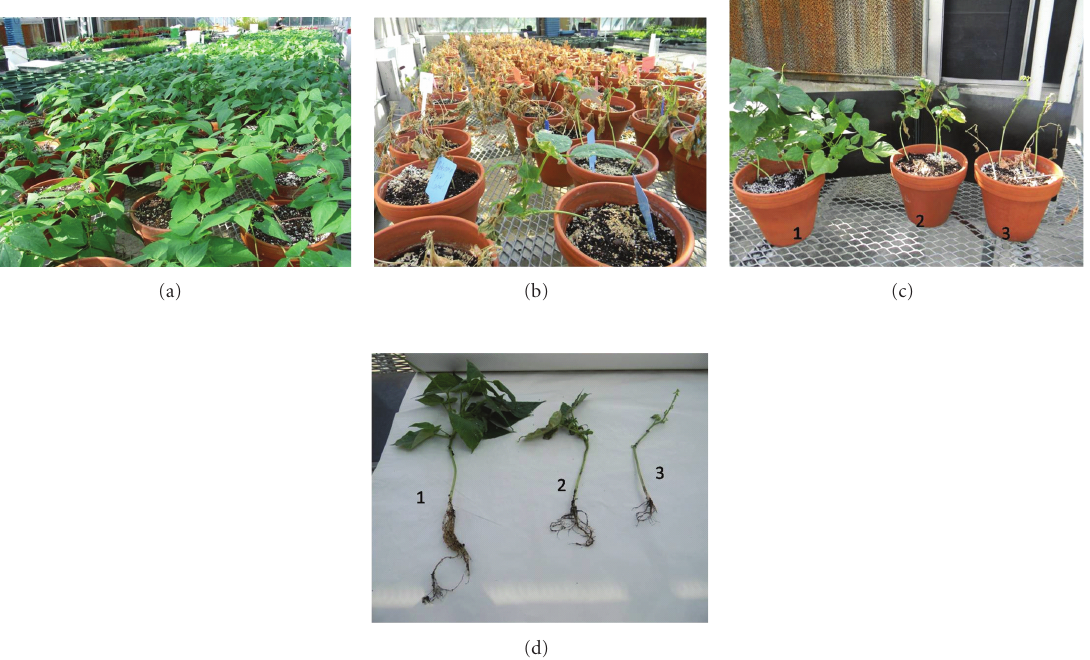
Figure 6: Drought tolerance assays. (a) “Matterhorn” plants before drought induction; (b) after 21 days of continuous water withholding; (c) “Matterhorn” drought recovered plants after water reapplication; 1: control non-transgenic plant that was watered throughout the experiment; 2: “Matterhorn” transgenic plant after 21 days of no-irrigation, 3: wild-type non-transgenic plant after 21 days of no-irrigation; (d) root growth in plants after 21 days of drought stress. 1: Control non-transgenic plant roots; these were watered daily, 2: transgenic plant roots after 21 days of no-irrigation, and 3: wild-type non-transgenic plant roots after 21 days of